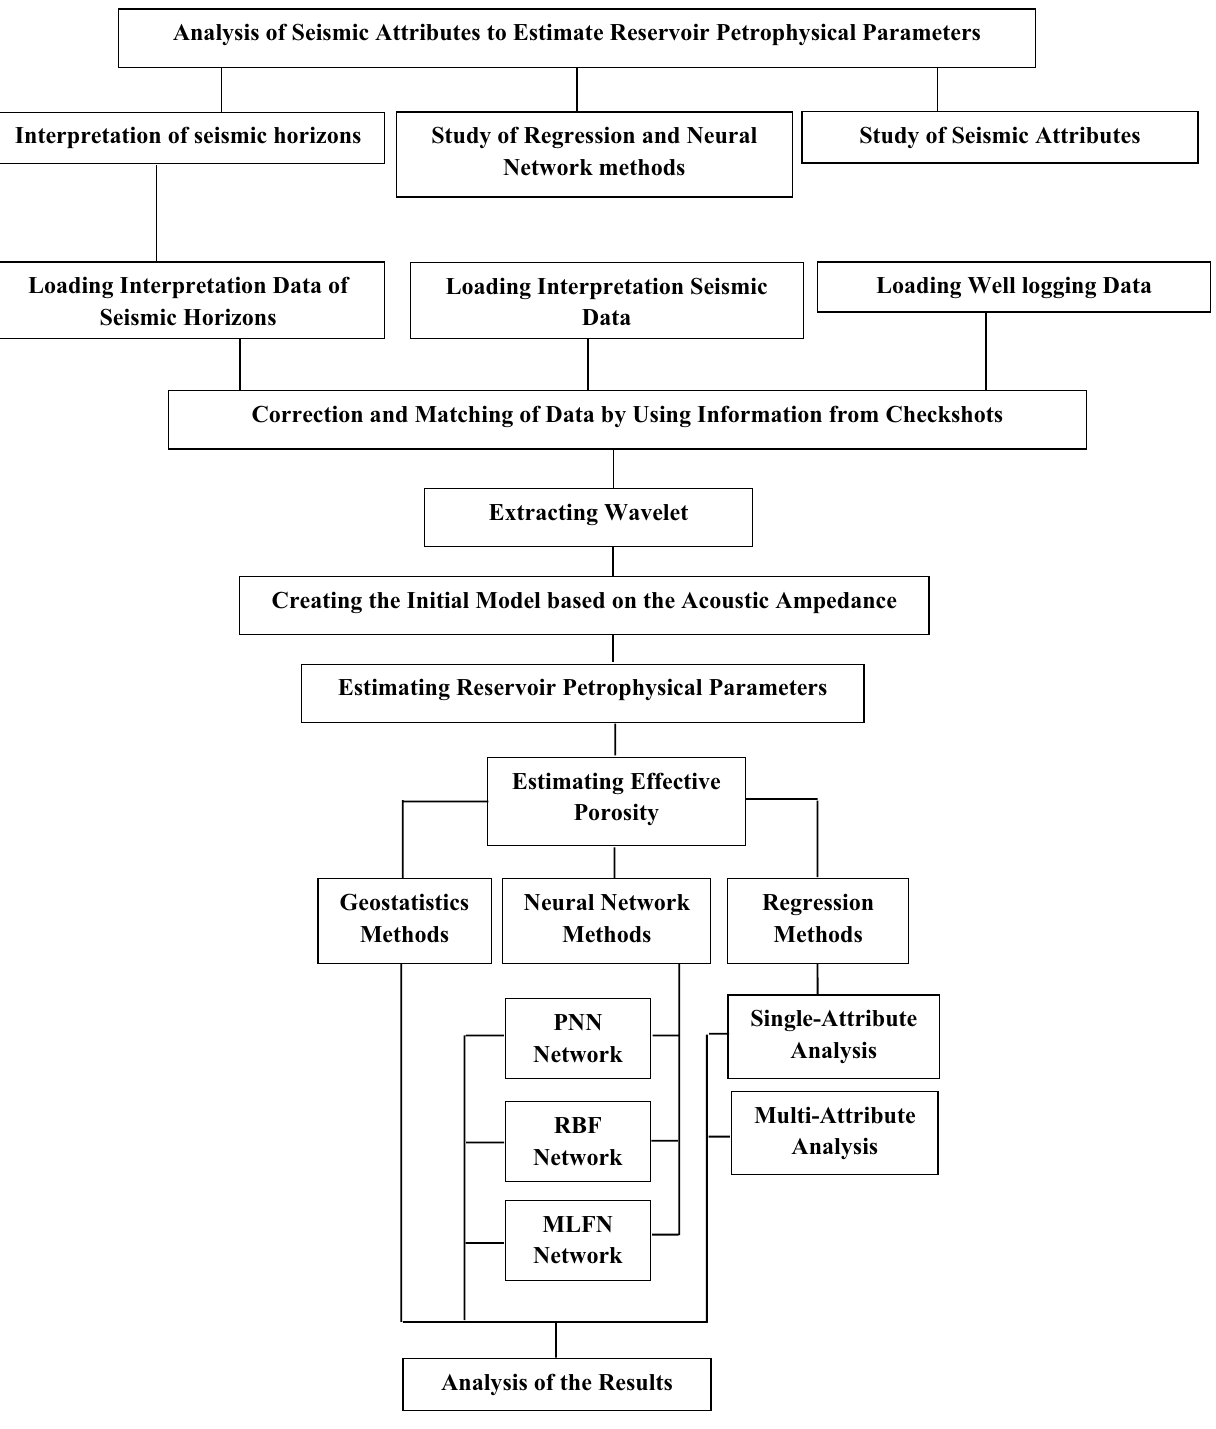
Fig. 5 Process used to estimate the effective porosity in the field of